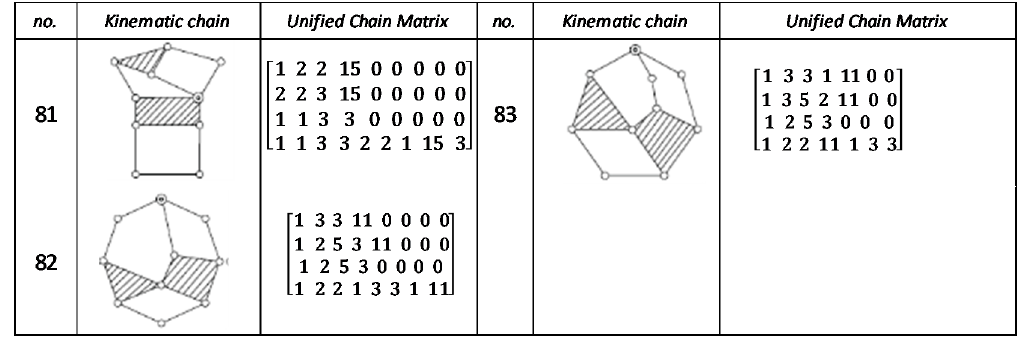
Figure A6. Unified chain matrix, UCM, for all 9-links of 2-DOF KCs with 1-multiple joint [25].